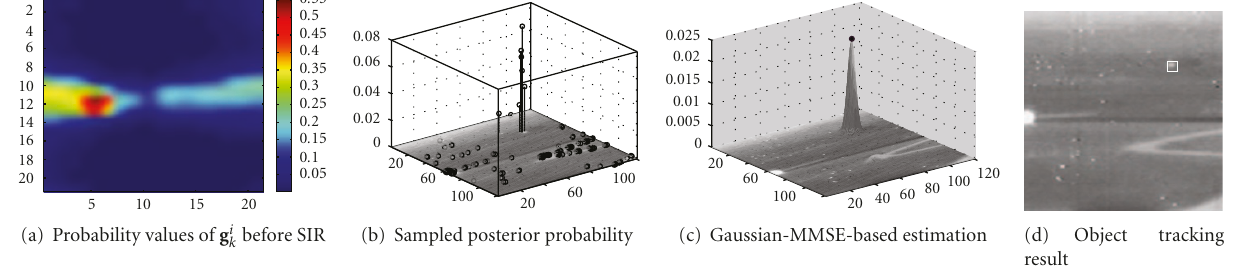
Figure 12: Tracking results for the BEH algorithm in a situation of strong